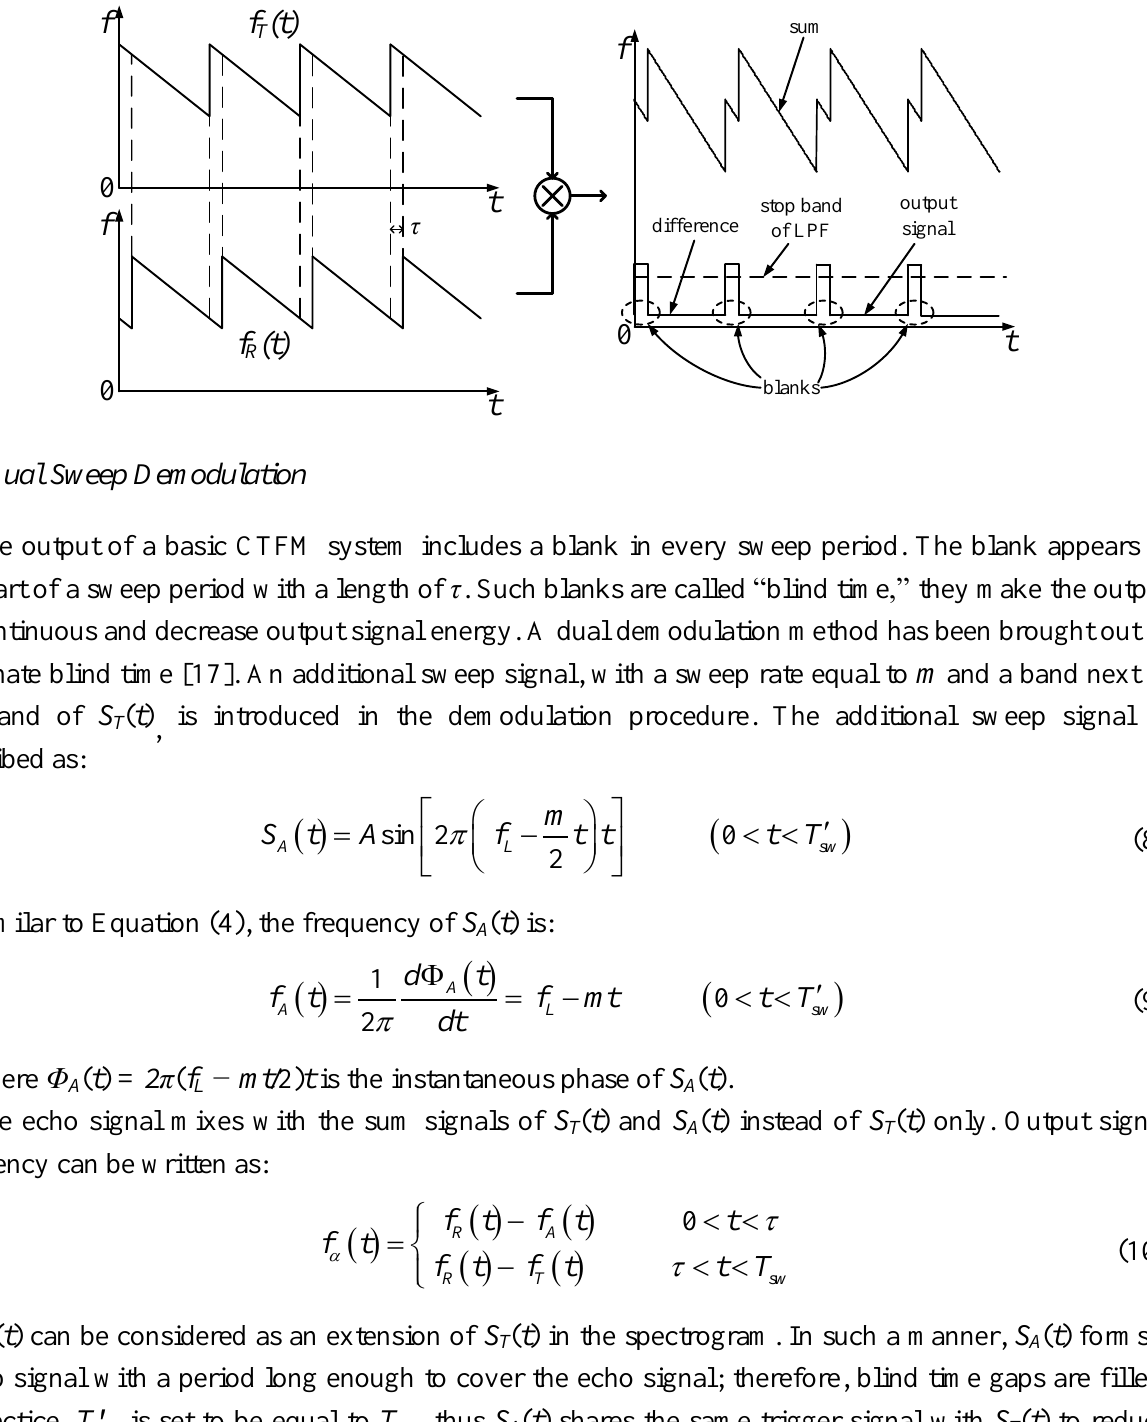
Figure 1. The signal spectrogram of the demodulation